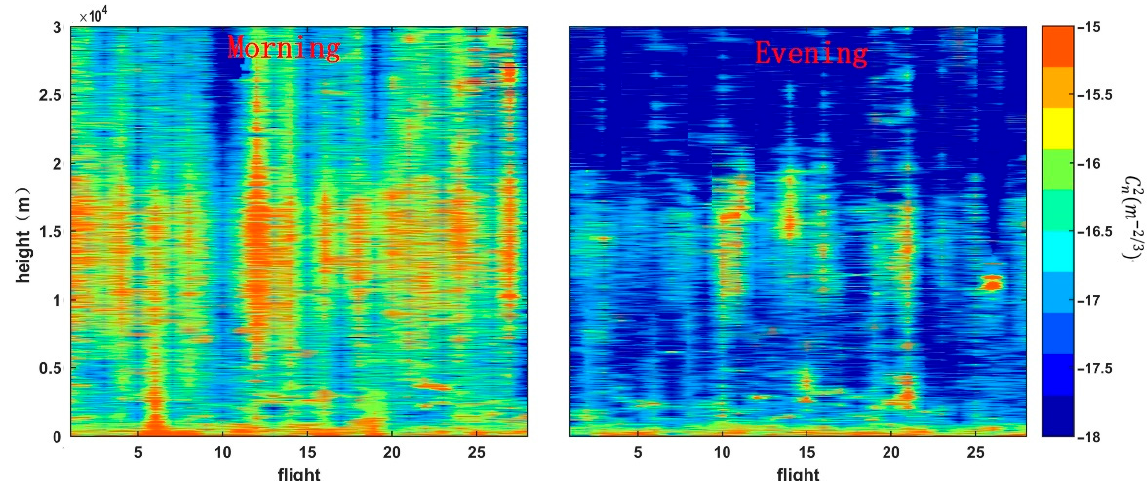
C at two moments over the offshore area. Figure 4. Vertical profiles distribution of C 2 n at two moments over the offshore n